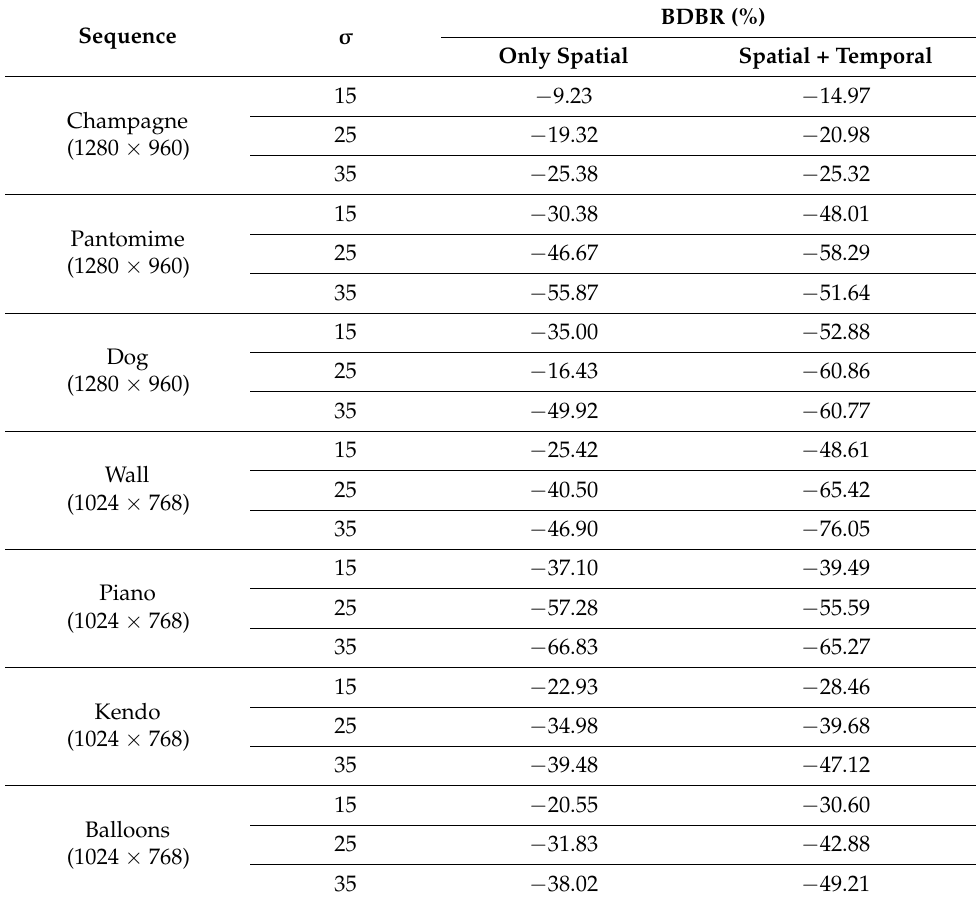
Table 6. Comparison of performance for noisy multi-views when using both spatial and temporal